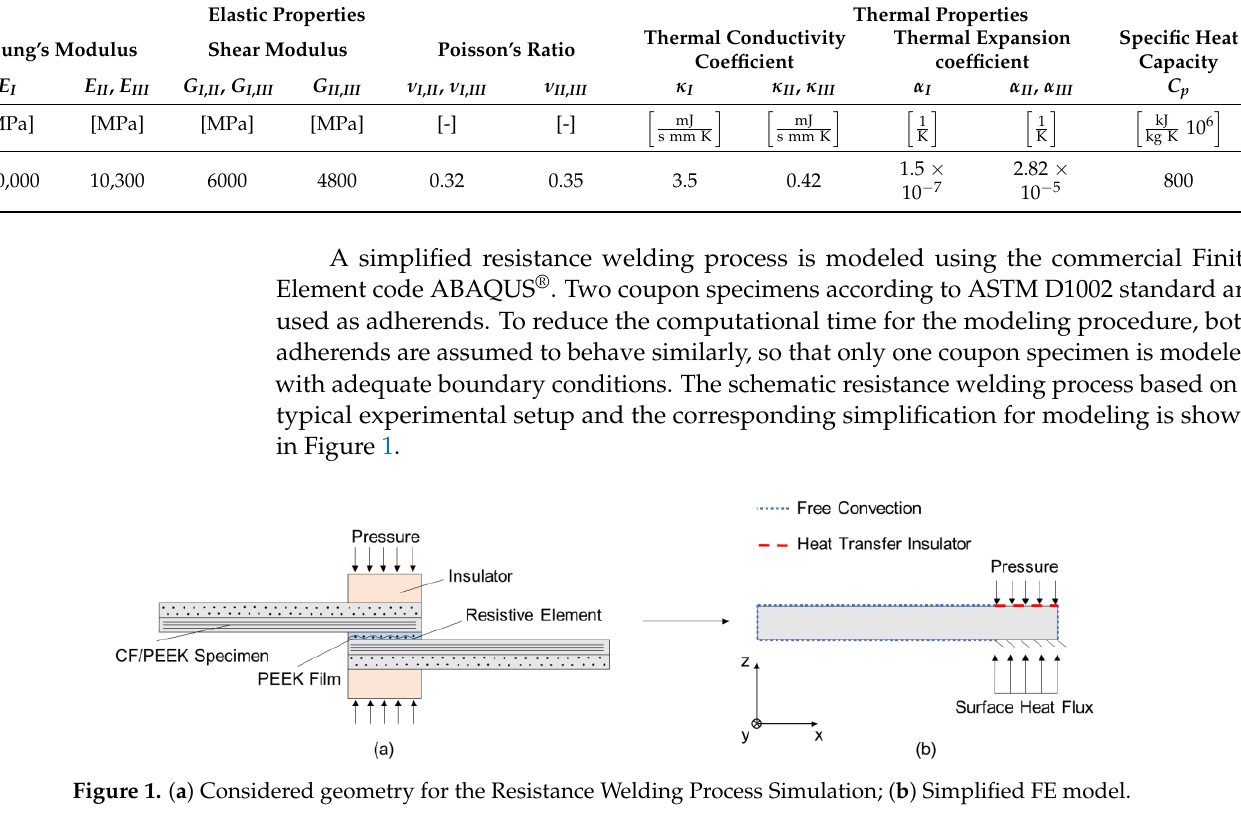
Table 1. Mechanical and thermal material properties at room temperature used in the FEM model [16]. Elastic Properties